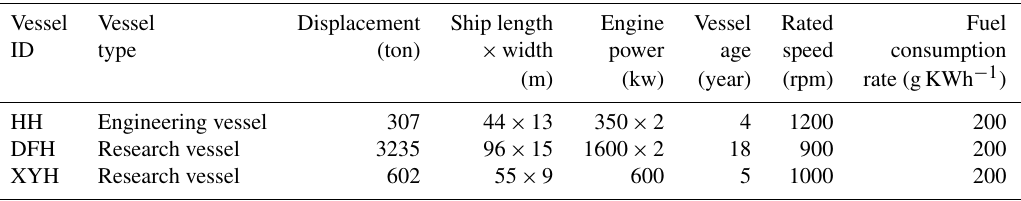
Table 1. Technical parameters of test vessels. Vessel